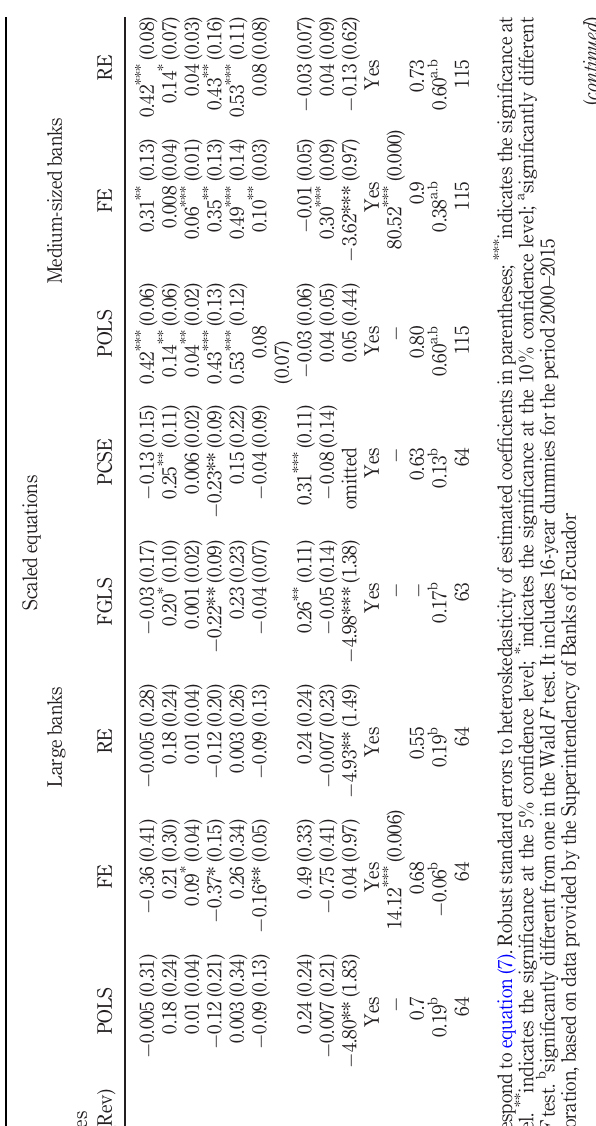
Table 6. P – R Model: